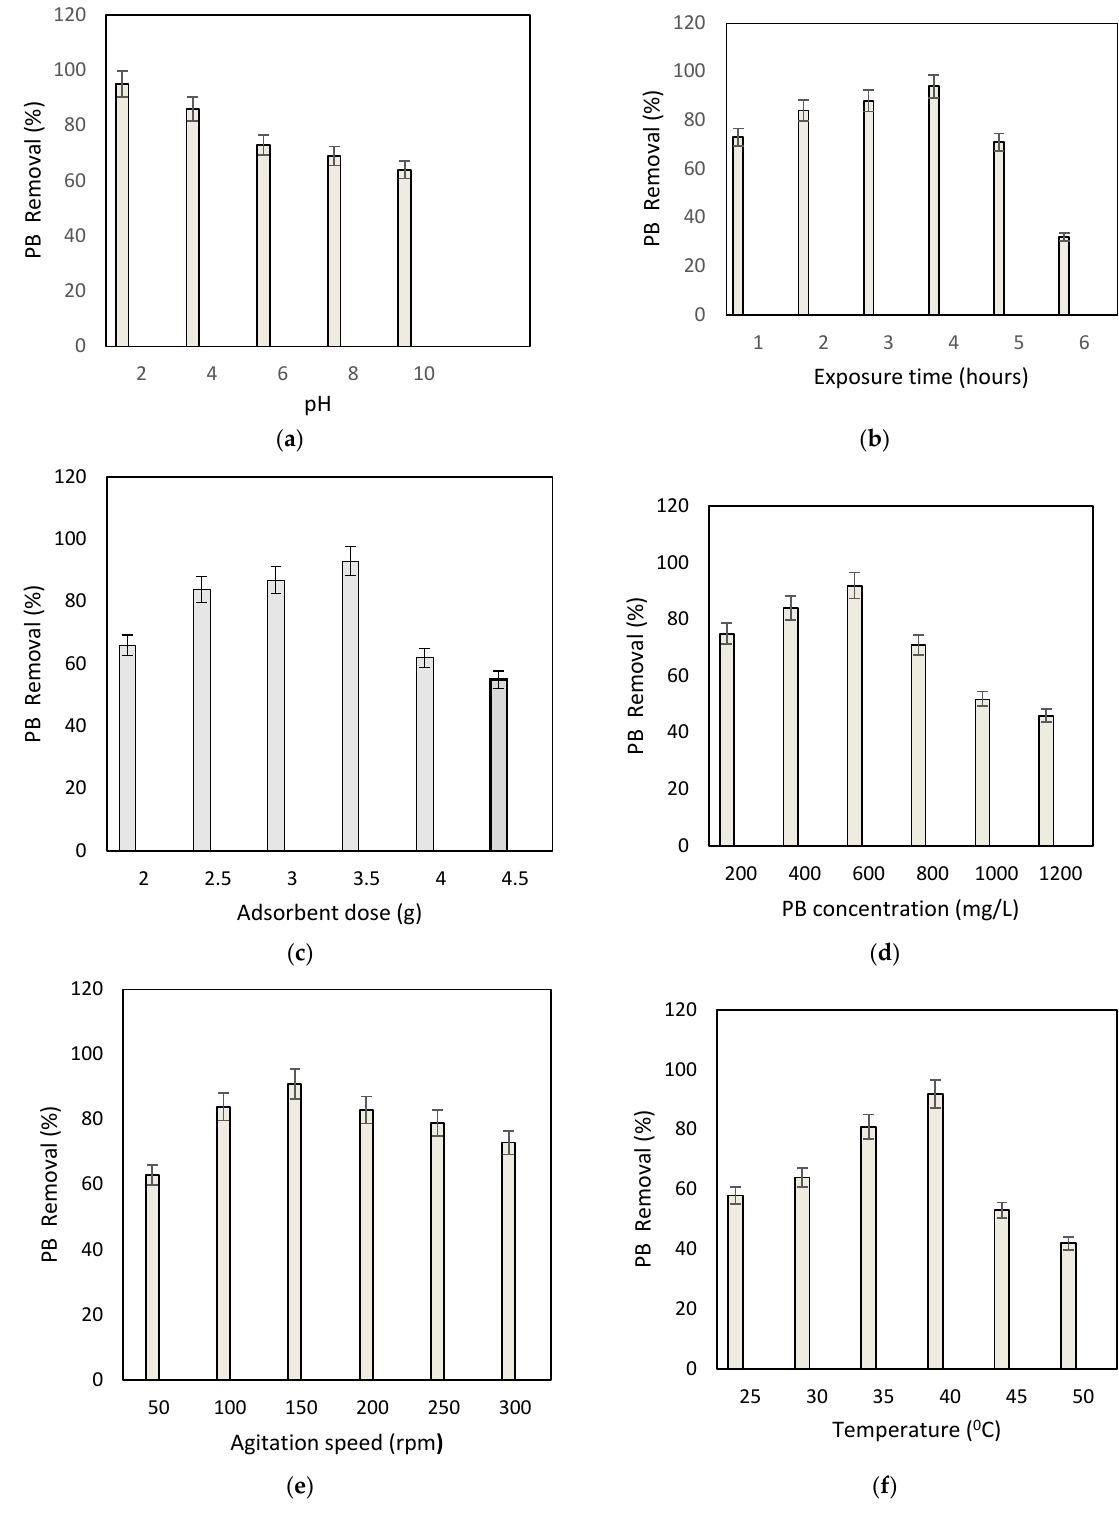
Figure 3. Impact of ( a ) pH, ( b ) contact time, ( c ) biochar amount, ( d ) dye concentration, ( e ) agitation speed, and ( f ) temperature on PB dye elimination with PFPB.